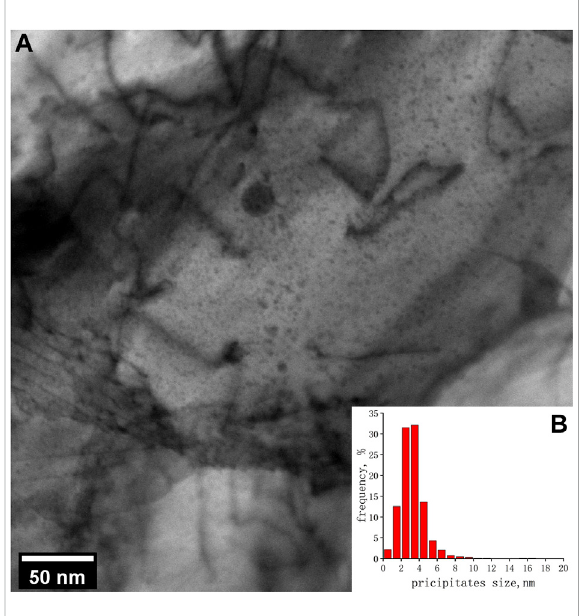
FIGURE 3 (A) High-density oxide nano-precipitates inside a grain